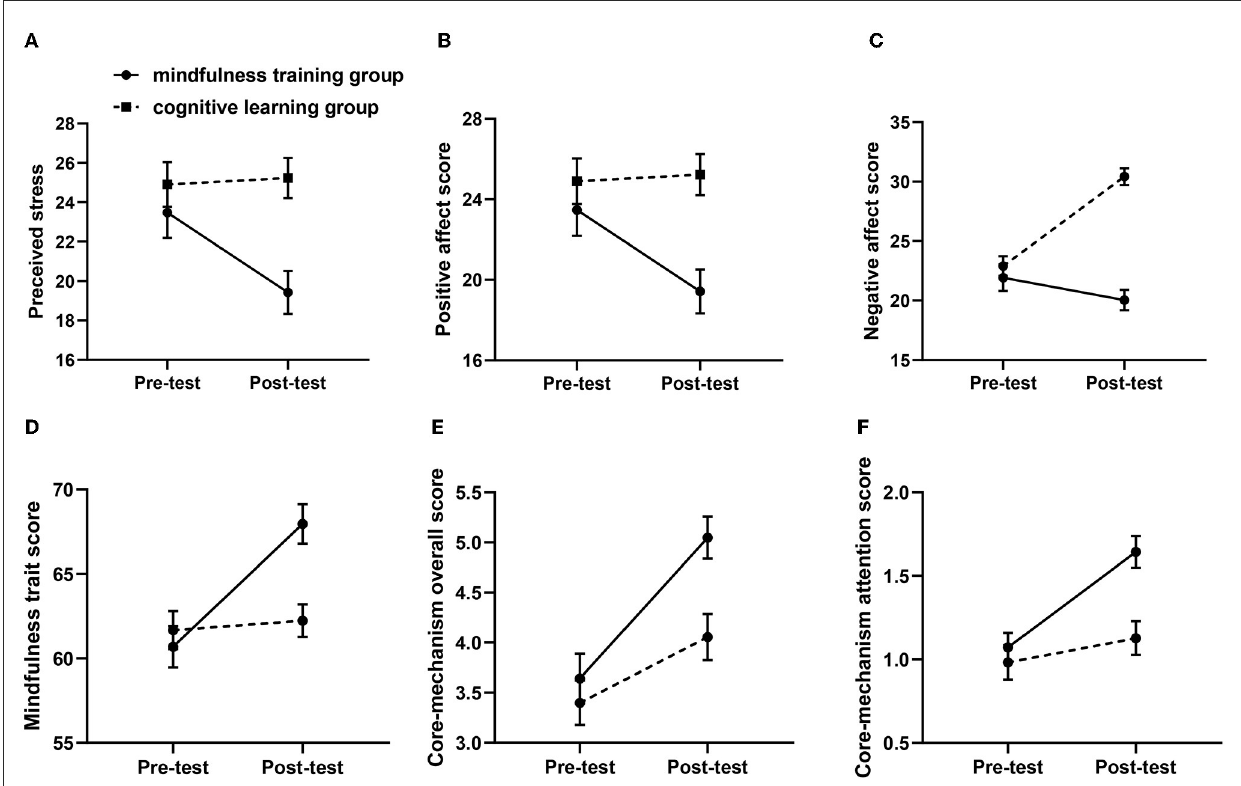
FIGURE2 (A–F) The effect of the psychological and cognitive intervention of the course in Phase 2.